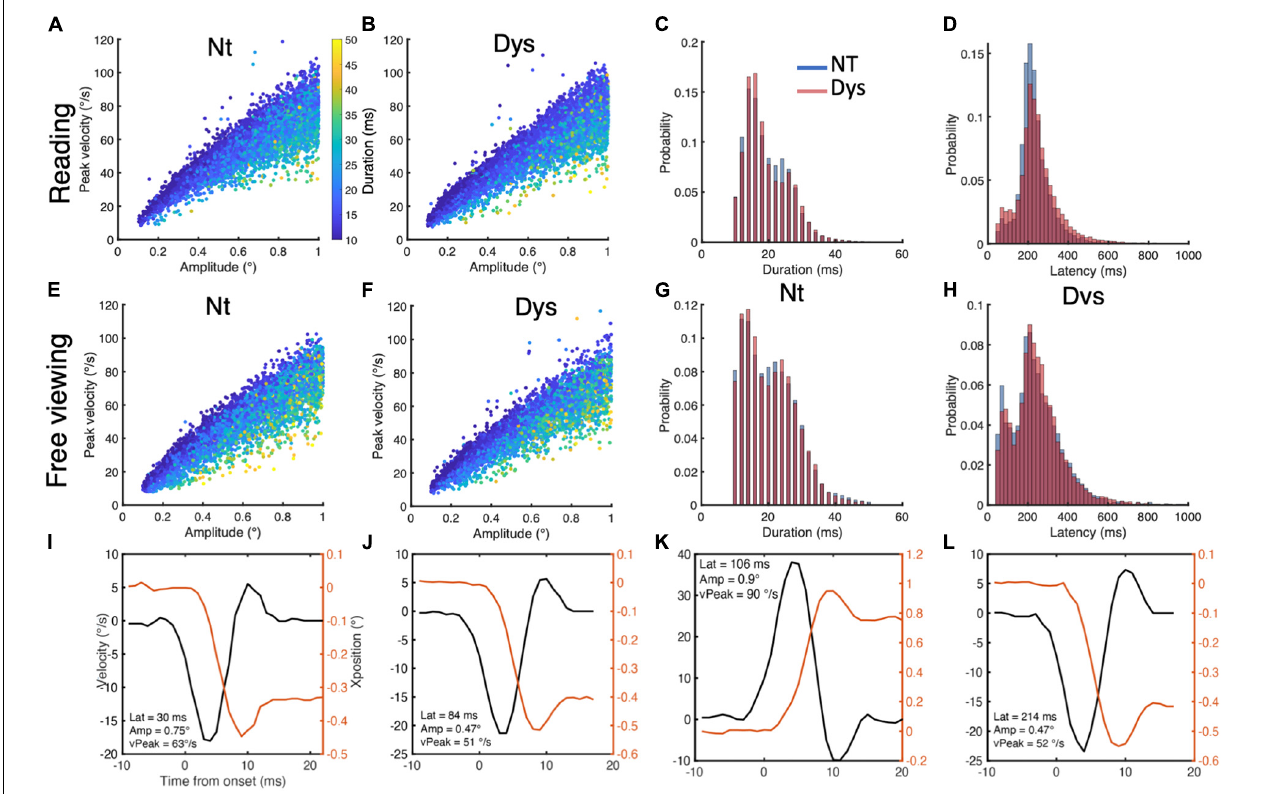
FIGURE 2 | Small saccade characteristics during reading and free viewing. Small saccade reading main sequence for neurotypicals (A) and dyslexics (B) , with duration overlay. (C) Small saccade duration distributions during reading for neurotypicals (blue) and dyslexics (red). (D) Small saccade latency distributions during reading for neurotypicals (blue) and dyslexics (red). Small saccade free viewing main sequence for neurotypicals (E) and dyslexics (F) , with duration overlay. (G) Small saccade duration distributions during free viewing for neurotypicals (blue) and dyslexics (red). (H) Small saccade latency distributions during free viewing for neurotypicals (blue) and dyslexics (red). (I–L) Positions and peak velocity profiles for small saccades of different latencies, amplitudes, and peak velocities.